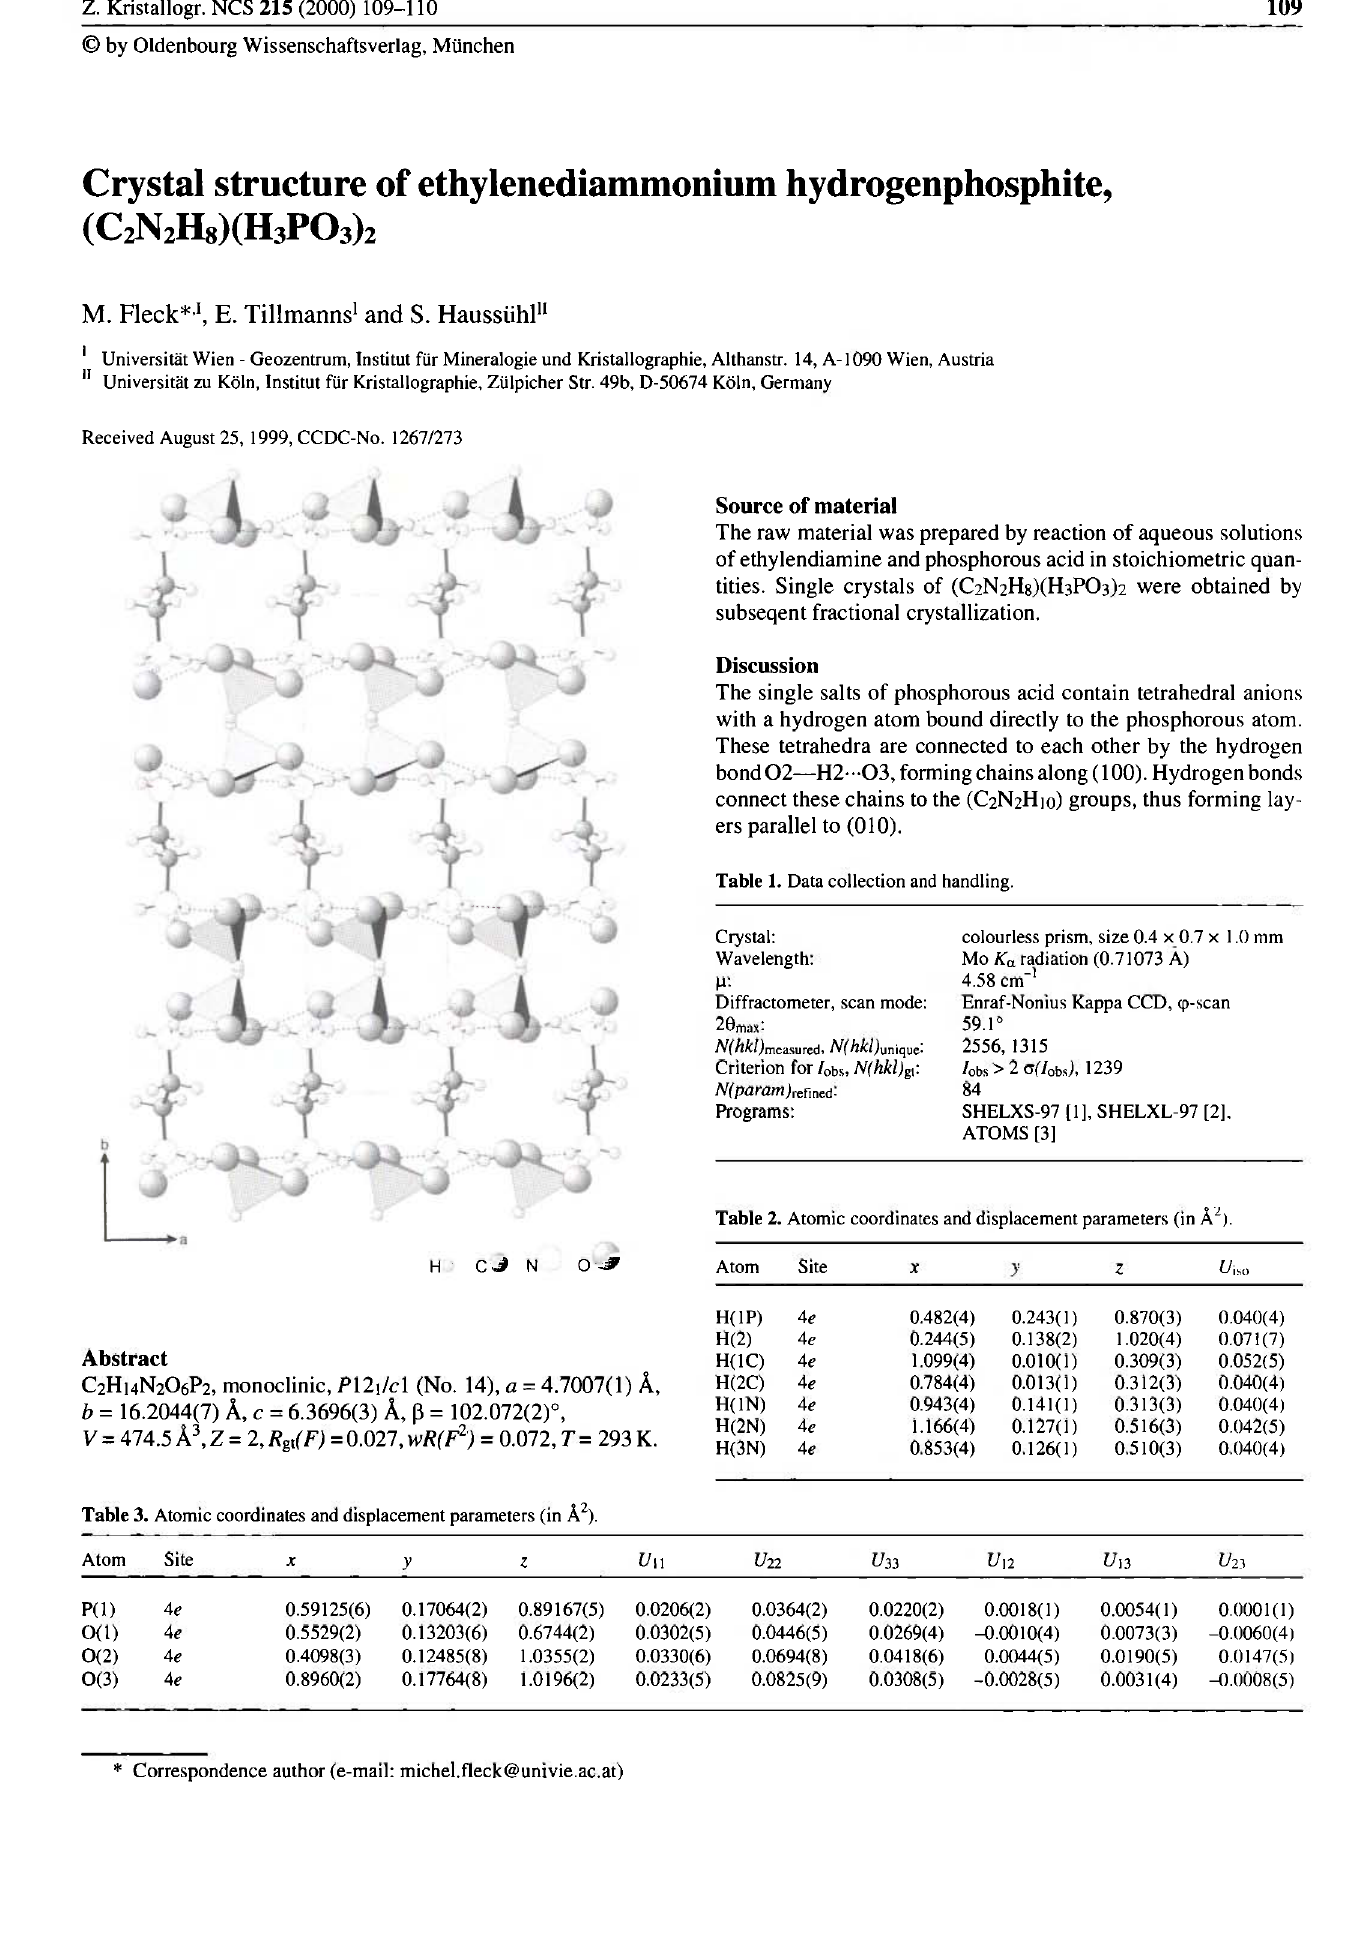
Table 3. Atomic coordinates and displacement parameters (in Ä 2 ).